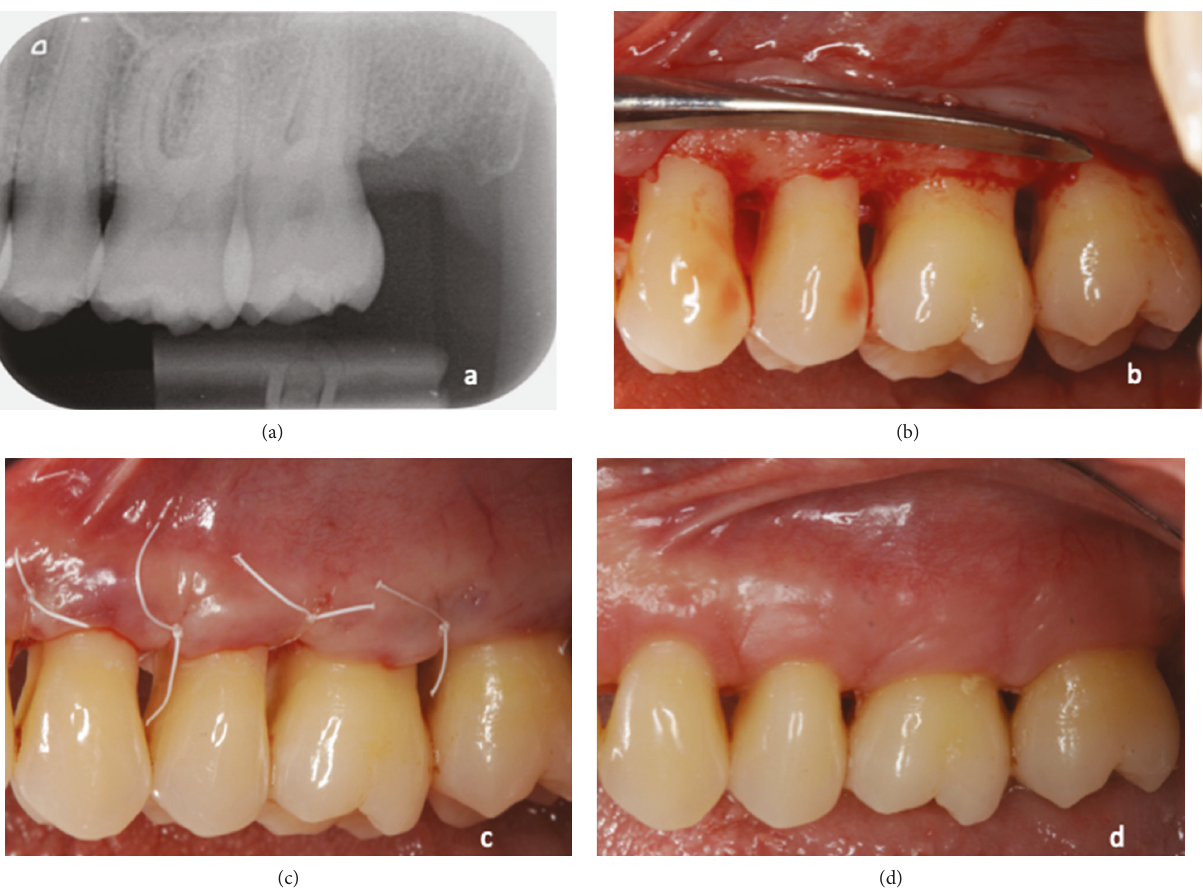
Figure 3: Modi fi ed Widman Flap was performed in sites with suprabony periodontal defects (a). After fl ap elevation, the granulation tissue was removed and roots were planned (b). Sites were closed with single external mattress suture (c). Sutures were removed 1 week after surgery